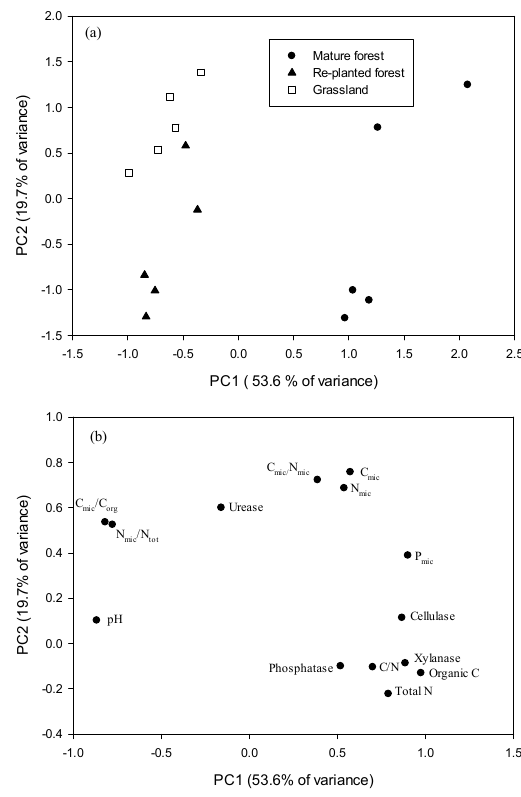
Figure 1. Plots of ( a ) the first 2 principal components (PCs) and ( b ) corresponding loading values in principal component analysis of the chemical and biochemical properties in the three types of